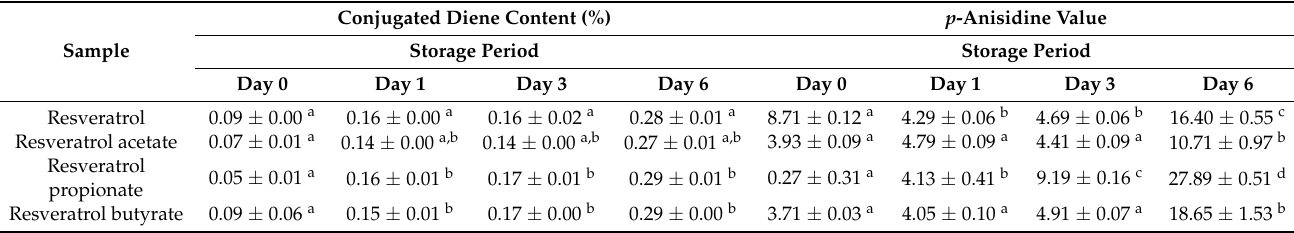
Table 2. Conjugated diene contents and p-anisidine values of stripped corn oil samples with added resveratrol and resveratrol esters over a 6-day period.